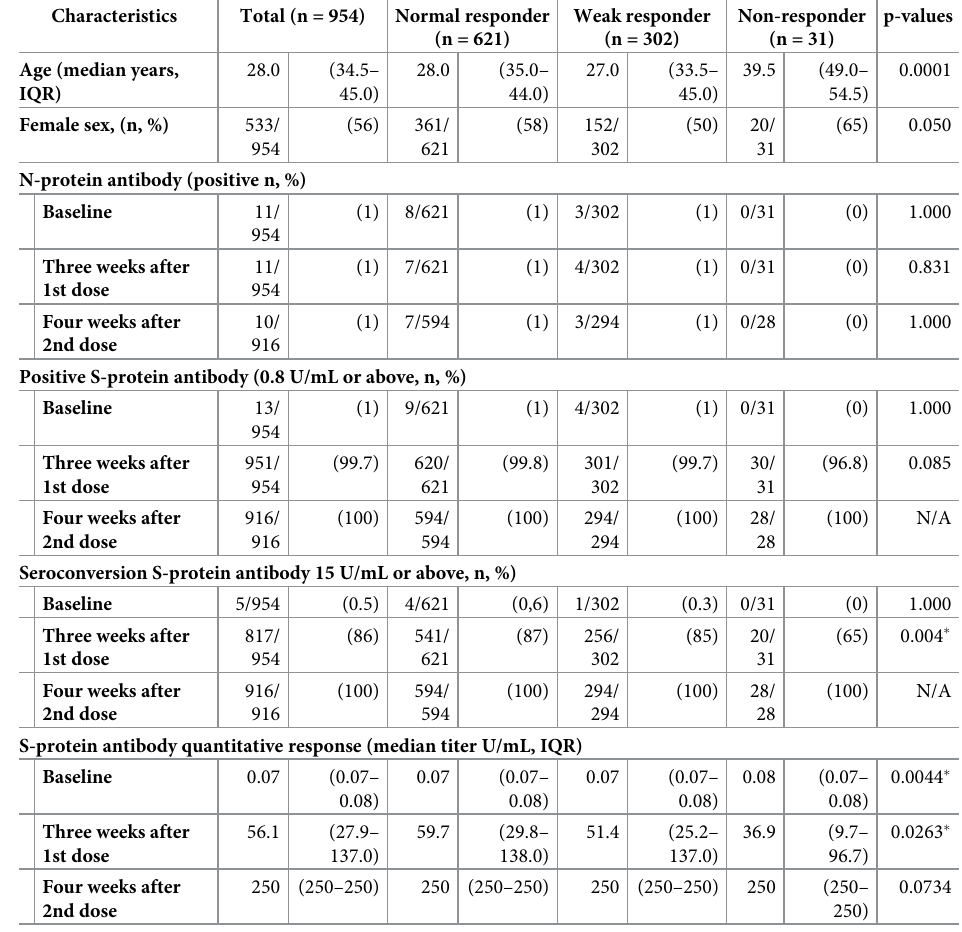
Numbers indicate median (IQR: interquartile range), n/N (%, 95% CI: confidence intervals) for outcomes. p-values for two-sided test of significance using Kruskal-Wallis H test for continuous variables and Fisher’s exact and Chi- squared tests for categorical variables. Normal HBV vaccine responders are those with HBs antibody titers � 100 mIU/mL. Weak HBV vaccine responders are those with HBs antibody titers between 10 and 100 mIU/mL. HBV vaccine non-responders are those with less than 10 mIU/mL HBs antibody response. Positive Anti-SARS-CoV-2 N- protein antibody results if COI (cut-off index) was � 1.0. � Denotes statistical significance at alpha = 0.05. N = nucleocapsid. S = spike.